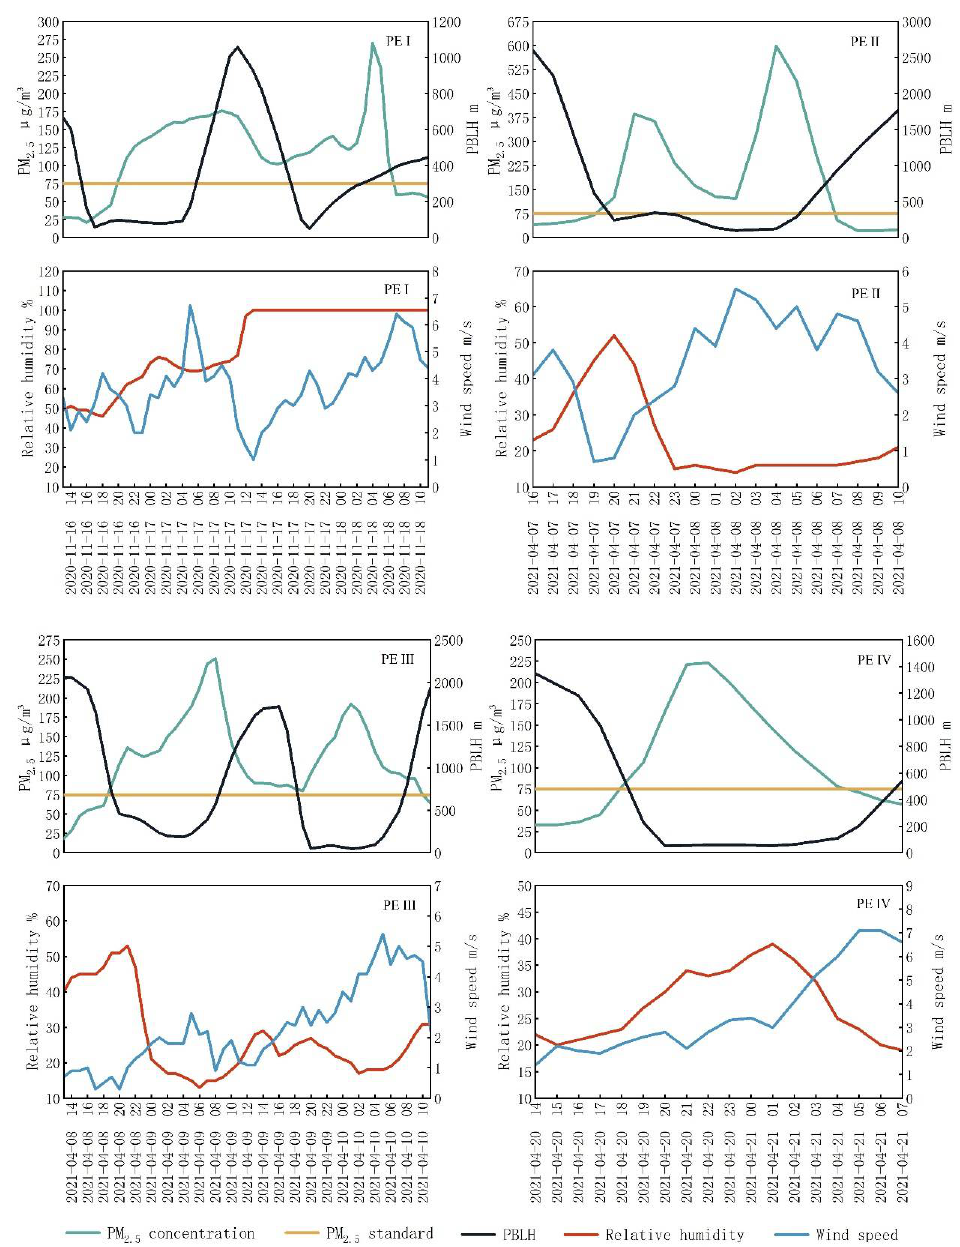
Figure 6. Hourly variations in PM 2.5 concentrations, PBLH, wind speed, and relative humidity for Changchun during each PE (time format: yyyy-mm-dd hh).